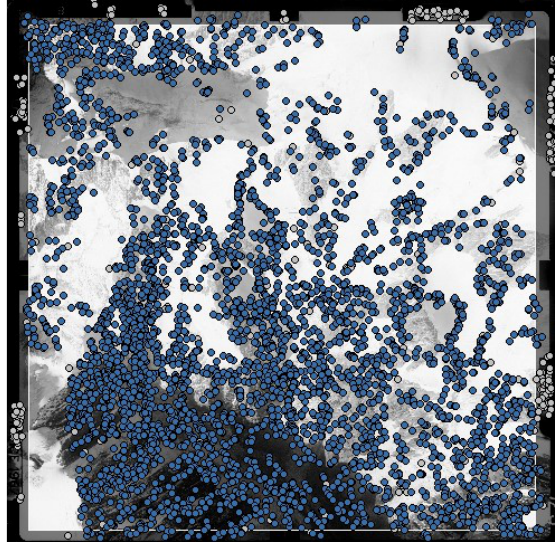
Figure 2. Example of an image from Dataset 1967 (panchromatic film recorded by analogue aerial camera Leica RC10) masked to avoid the interference of the outer frame during Structure-from-Motion (SfM). Overlaid points represent extracted tie points, while blue points are the ones which passed the internal blunder rejection (acknowledgements to IGNF ® for the aerial